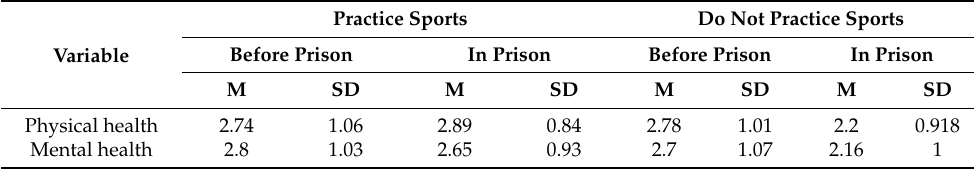
Table 6. Descriptive statistics of physical and mental health based on sports